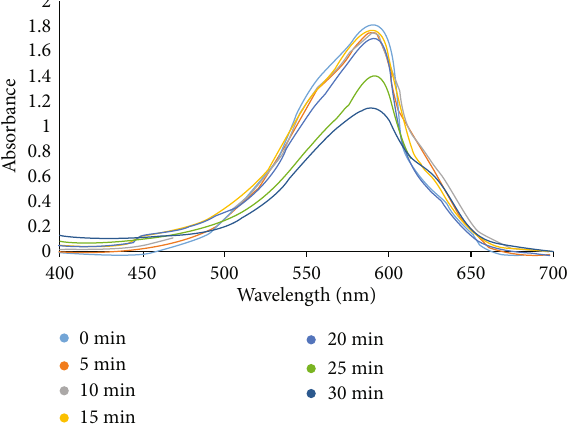
Figure 11: FESEM images (a – f) of conc. H